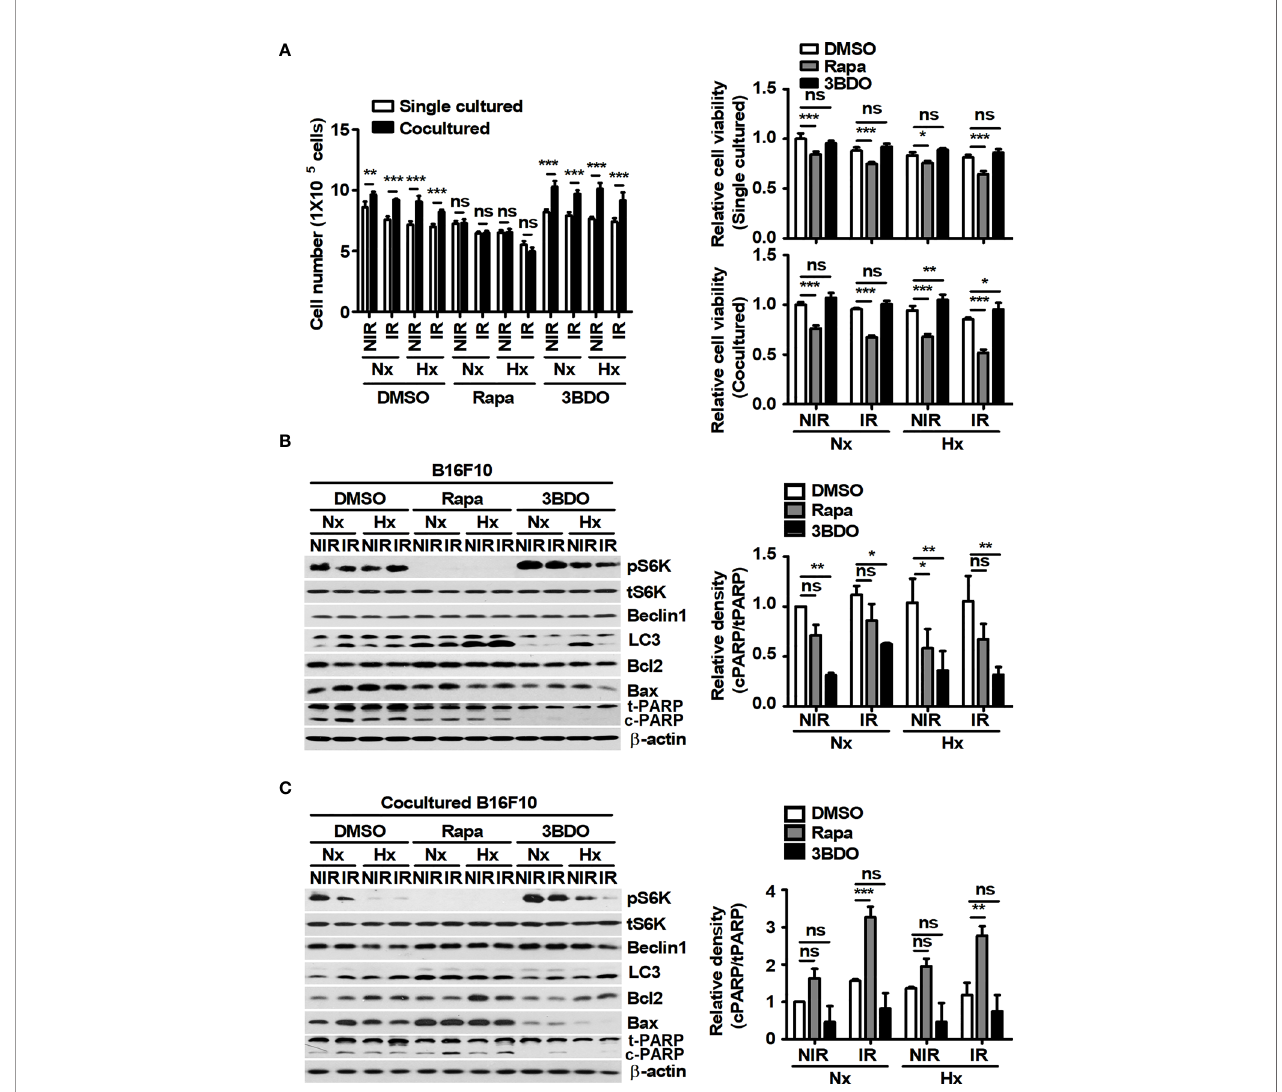
FIGURE 2 | Pharmaceutical regulation of mTOR activation affects macrophage-mediated B16F10 cell survival. B16F10 cells cultured alone or cocultured with BMDMs were incubated in the presence of 100 nM rapamycin or 100 nM 3BDO at 37°C/5% CO 2 in a normoxic (Nx) chamber or 37°C/1% O 2 in a hypoxic (Hx) chamber for 3 h. After 3-Gy g -irradiation, B16F10 cells were incubated under the indicated conditions for 21 h. (A) Cell viability was measured by an automated cell counter. (B, C) The protein levels of p70 S6K, phospho-p70 S6K, Beclin1, LC3, Bcl2, Bax, and PARP in B16F10 cells were evaluated by western blotting. b -actin was used as an internal control. The band density of each sample was measured with ImageJ. The bars and error bars represent the mean ± SD; * P < 0.05; ** P < 0.01; *** P < 0.001; ns, not signi fi